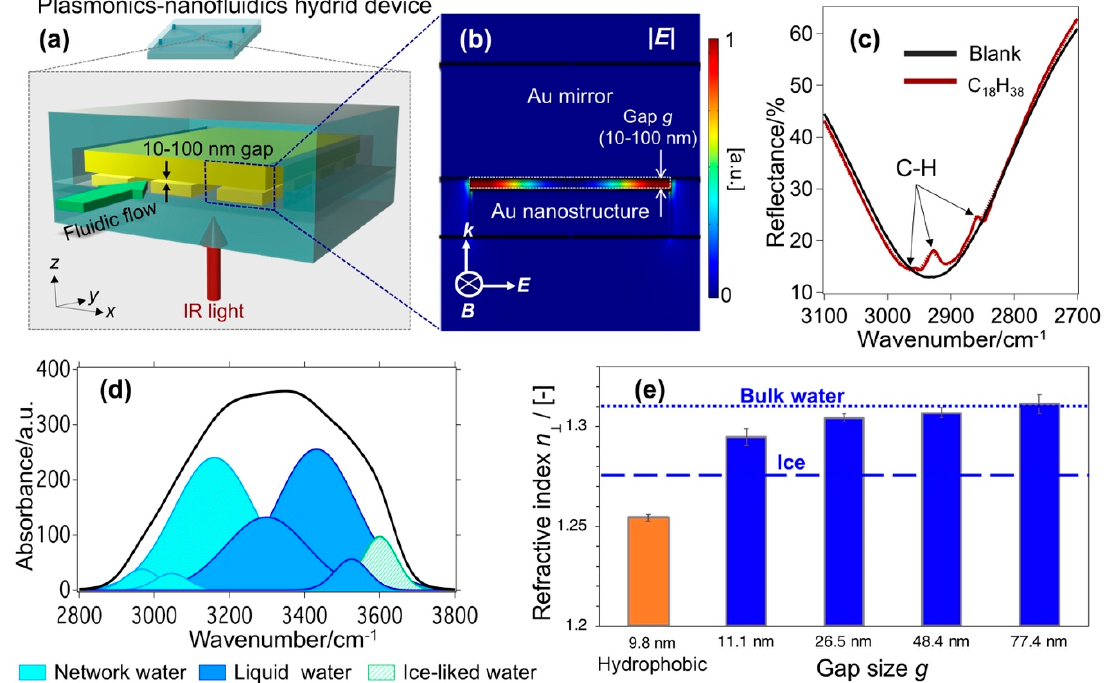
Figure 3. ( a ) Plasmonics-nanofluidics hybrid device consisting of an Au mirror and an array of periodic Au nanostructures separated by a nanofluidic channel, ( b ) the numerical calculation result of electric fieldprofile | E | indicatingtheaccumulationoflightenergyinsidethenanogapashot-spots, ( c )vibrational modes of target molecules detected as peaks in the reflectance dip of the original plasmon resonance (adapted with permission from [60]. Copyright 2017 American Chemical Society), ( d ) vibrational absorption of water confined in a 10 nm gap (adapted with permission from [61]. Copyright